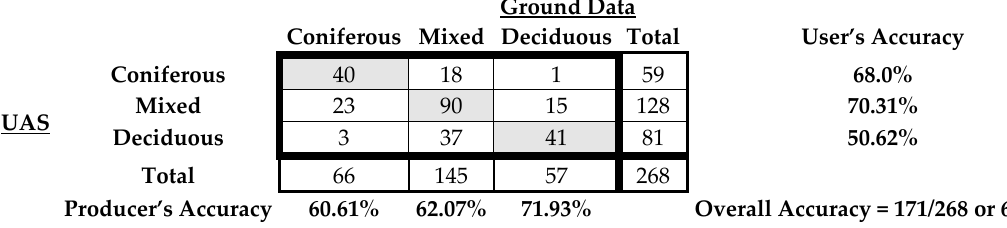
Table 5. Stratified randomly distributed OBC reference data subsample error matrix. Ground (reference) data are represented by the CFI plots and Unmanned Aerial Systems (UAS) data are derived from the corresponding orthomosaic.